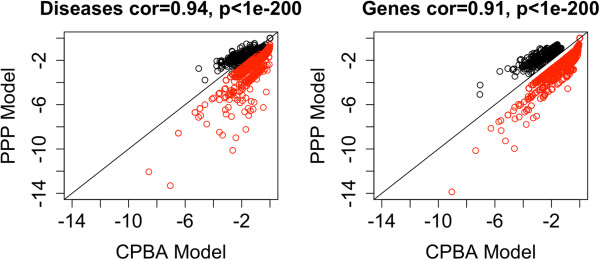
OMIM CPBA versus PPP Analysis. Scatterplot of the Log10(P) values obtained from analysis of OMIM using 14 and 10 clusters versus a single cluster for the Disease network and Gene network respectively. Note that the points are colored based on whether they come from a pair within a cluster(red) or between two clusters(black). This is very telling as it shows that by conditioning on the clustering, CPBA is able to increase its sensitivity in finding intercluster pairs while at the same time toning down that same trait in intracluster pairs.